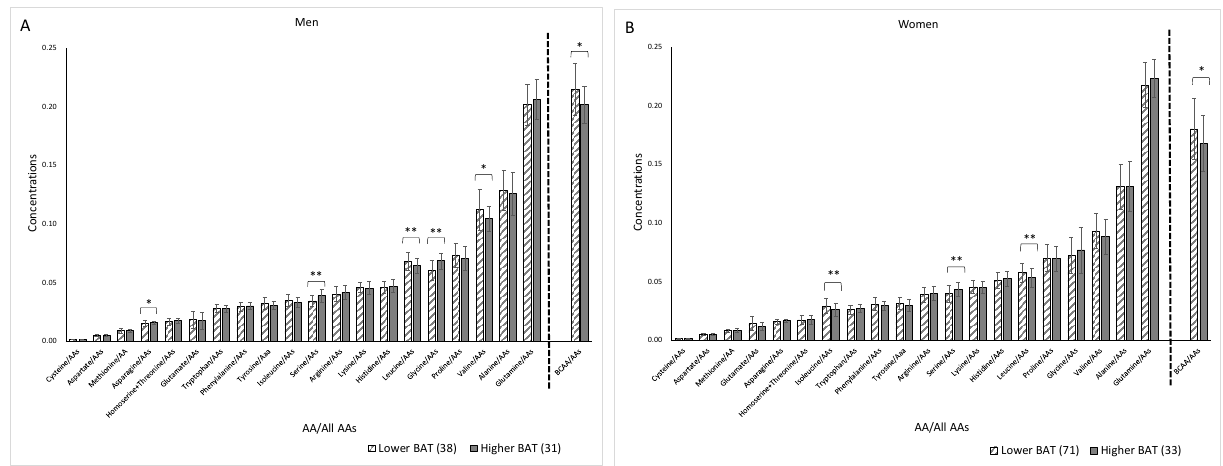
Figure 8. Differences in concentrations in amino acids (AAs) between higher BAT-d (>74 µ M of [total-Hb]sup) and lower BAT-d (<74 µ M of [total-Hb]sup) separately for men ( A ) and women ( B ). The numbers of participants in the higher and lower BAT-d groups were 31 and 38 in men and 33 and 71 in women, respectively. BCAAs, branched-chain amino acids; [total-Hb]sup, total hemoglobin concentration in the supraclavicular region. * p < 0.05, ** p < 0.01. The area under the ROC curve determined by [total-Hb]sup to be closest to (0, 1) for the predicted formula determined by the AAs and anthropometric parameters provided an area under the ROC curve (AUC) of 0.92 (95% confidence interval [CI] 0.86 – 0.98, p < 0.001) in men and 0.78 (95% CI 0.69 – 0.88, p < 0.001) in women if the cut-off value of total Hb was set to 74.0 µM. The sensitivity was 94% with a specificity of 74% in men and 70% with a specificity of 76% in women (Figure 9A, B).